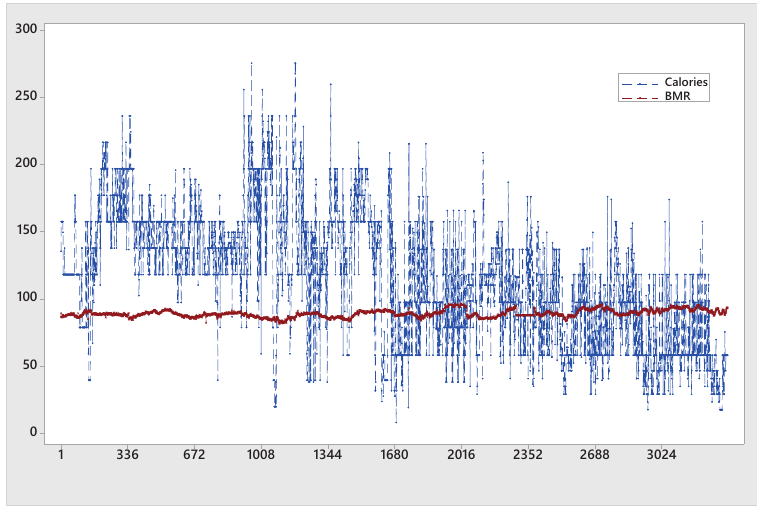
Fig. 3 2004-2014 SMR vs. BMR example plot